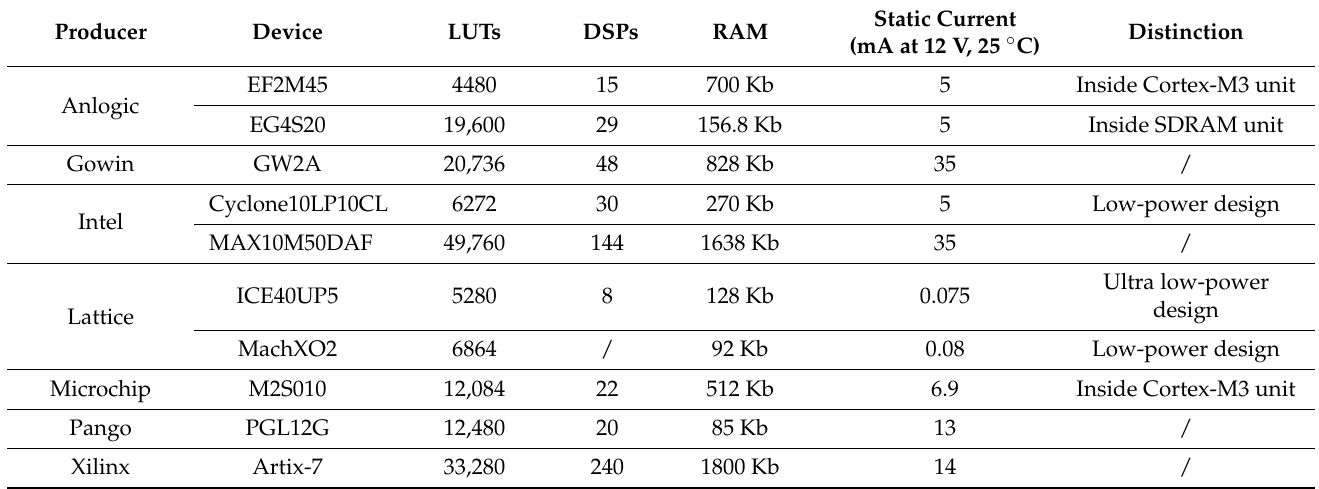
Table 3. The resource of 10 different FPGAs.